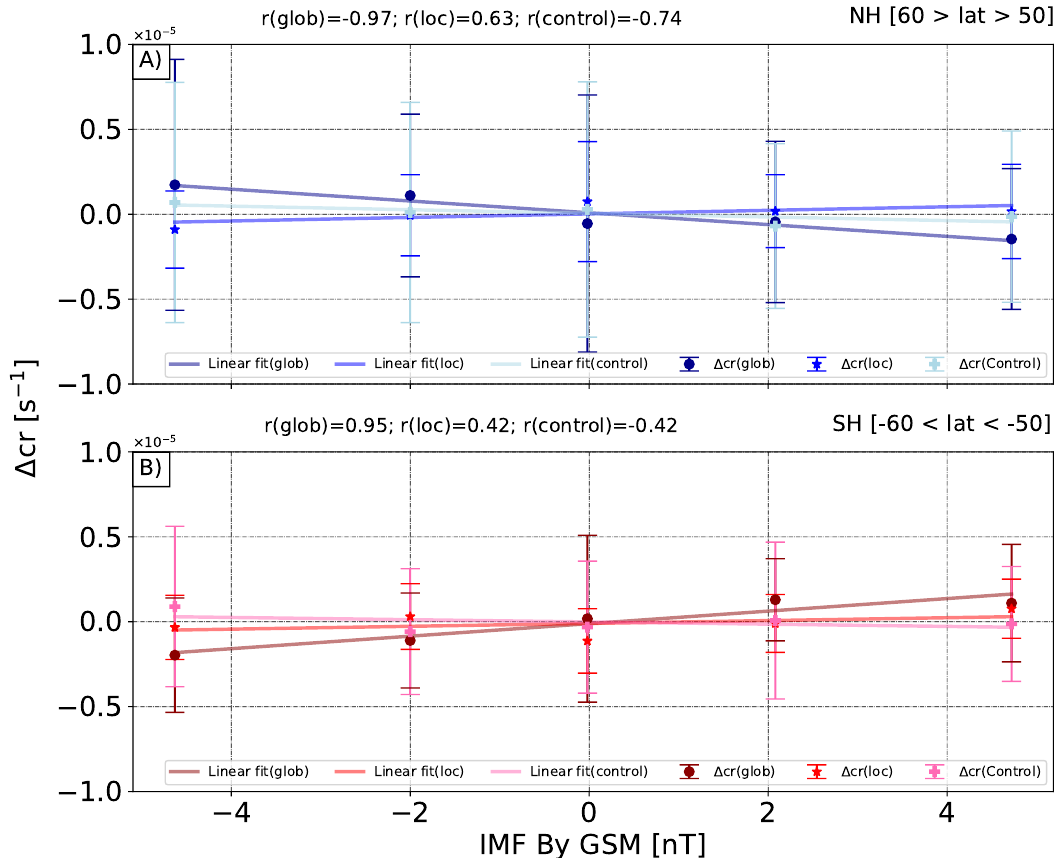
Figure 4. Ensemble-mean linear regression of ∆ cr and daily-mean IMF B y for the 1999–2002 period for mid-latitudes. Data were binned and averaged for five daily-mean IMF B y intervals (see experiment description). Dark blue and dark red: B y (glob) experiment; blue and red: B y (loc) experiment; light blue and pink: the control experiment. Panel ( A ): ∆ t for Northern Hemisphere mid-latitudes (60 > lat > 50); panel ( B ): ∆ t for Southern Hemisphere mid-latitudes ( − 60 < lat < − 50). Error bars are plus/minus standard error in the mean of ∆ cr between ensemble members. r represents Pearson’s correlation